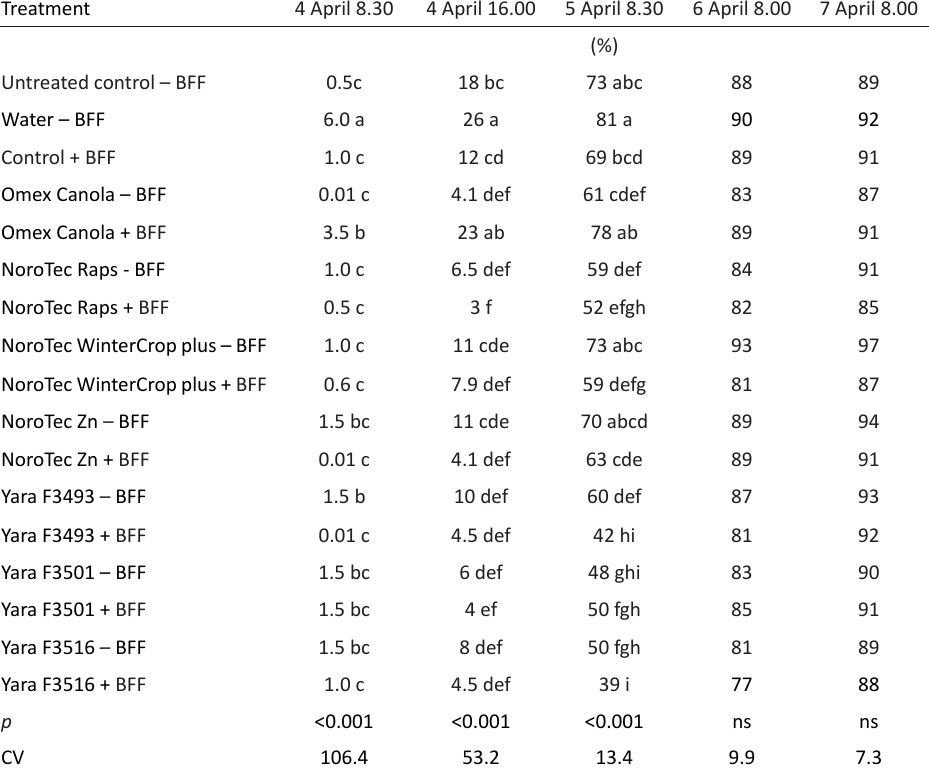
Table 6. Average emergence of spring oilseed rape (cv. Majong) in a seed vigour test at various times. Seeds were treated with mineral nutrient products and with (+) and without (–) the application of binder, filler and Rovral (BFF), in 2017,